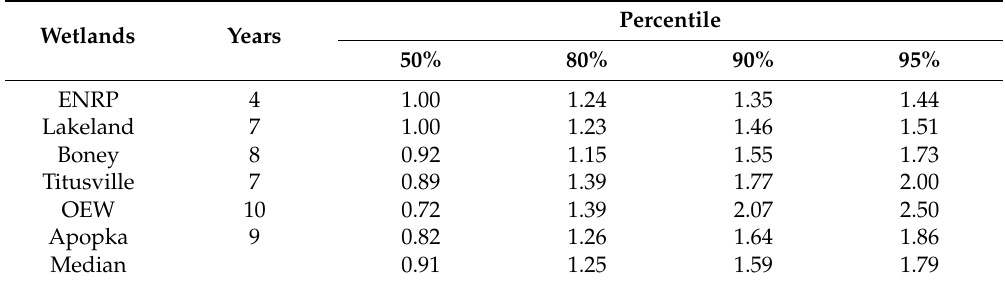
Table 5. Multipliers for monthly trends in total phosphorus exiting large steady flow wetlands.